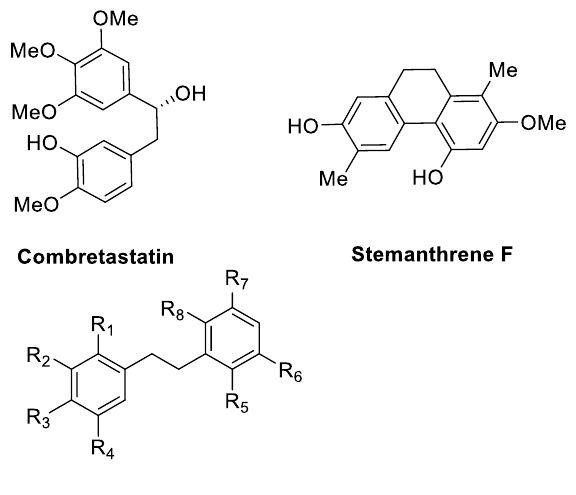
Figure 7. Structures of combretastatin from Shen et al . (2009) [32], stilbostemins and Stemanthrene F. from Yang et al . (2006) [71]. Table 10. Antibacterial activity of stilbostemins, stemanthrene and compounds 8 and 9 in MIC values ( µ g / mL) from Yang et al. (2006) [71]. Compound S. aureus S. epidermidis J > 50 > 50